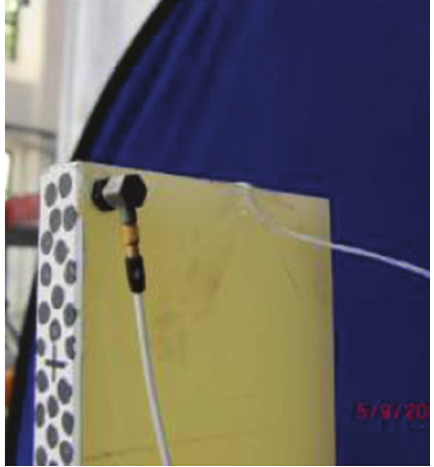
Figure 5: Installed accelerometer at the end of tested sample.